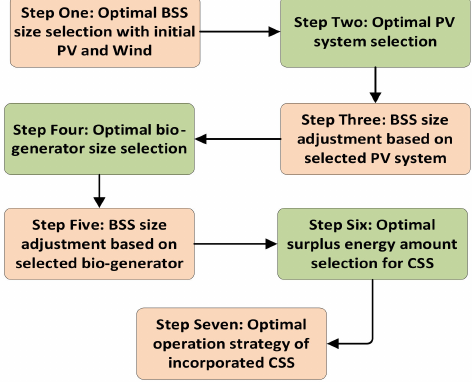
Figure 9. Seven-step approach to achieve the study’s